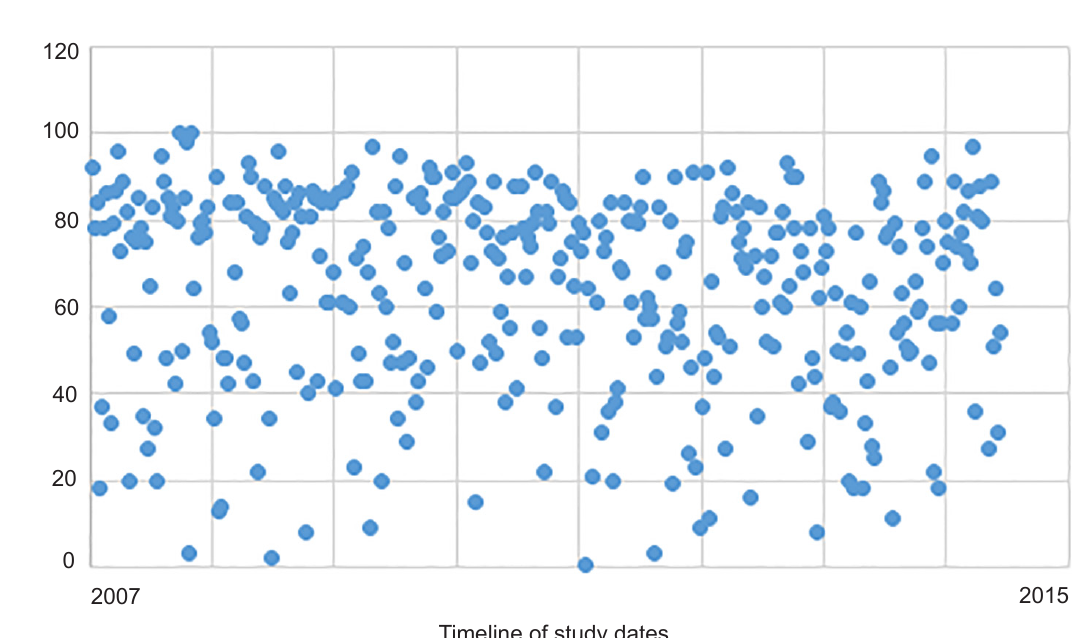
Figure 3. Scatter plot of ages of patients triaged to basic life support and admitted to critical